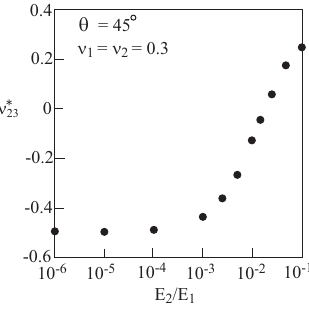
Figure 6. Re-entrant array ( θ = 45 ◦ ) with two distinct materials. Variation of the effective with the Young’s modulus of material 2 while keeping its Poisson’s Poisson’s ratio ν ∗ 23 ratio